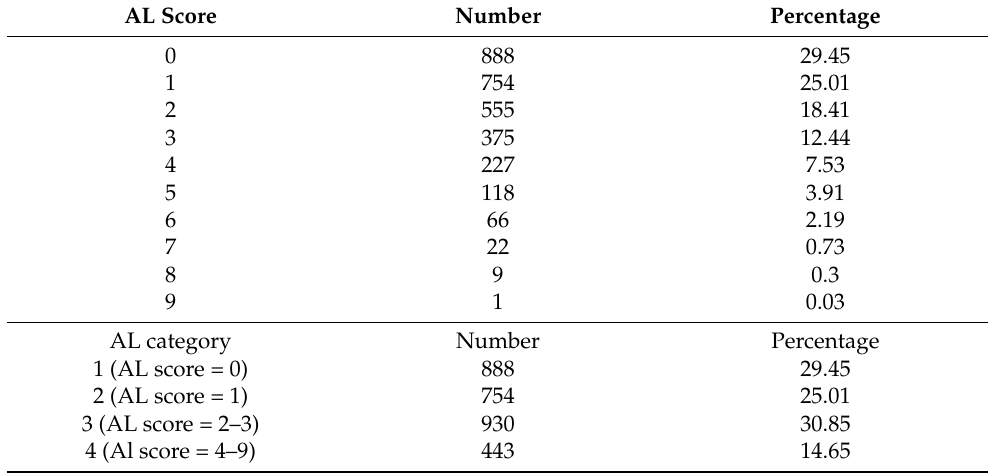
Table 2. Distribution of AL scores and AL